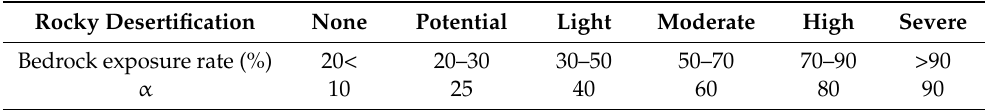
Table 1. α values for different karst rocky desertification classes. Rocky